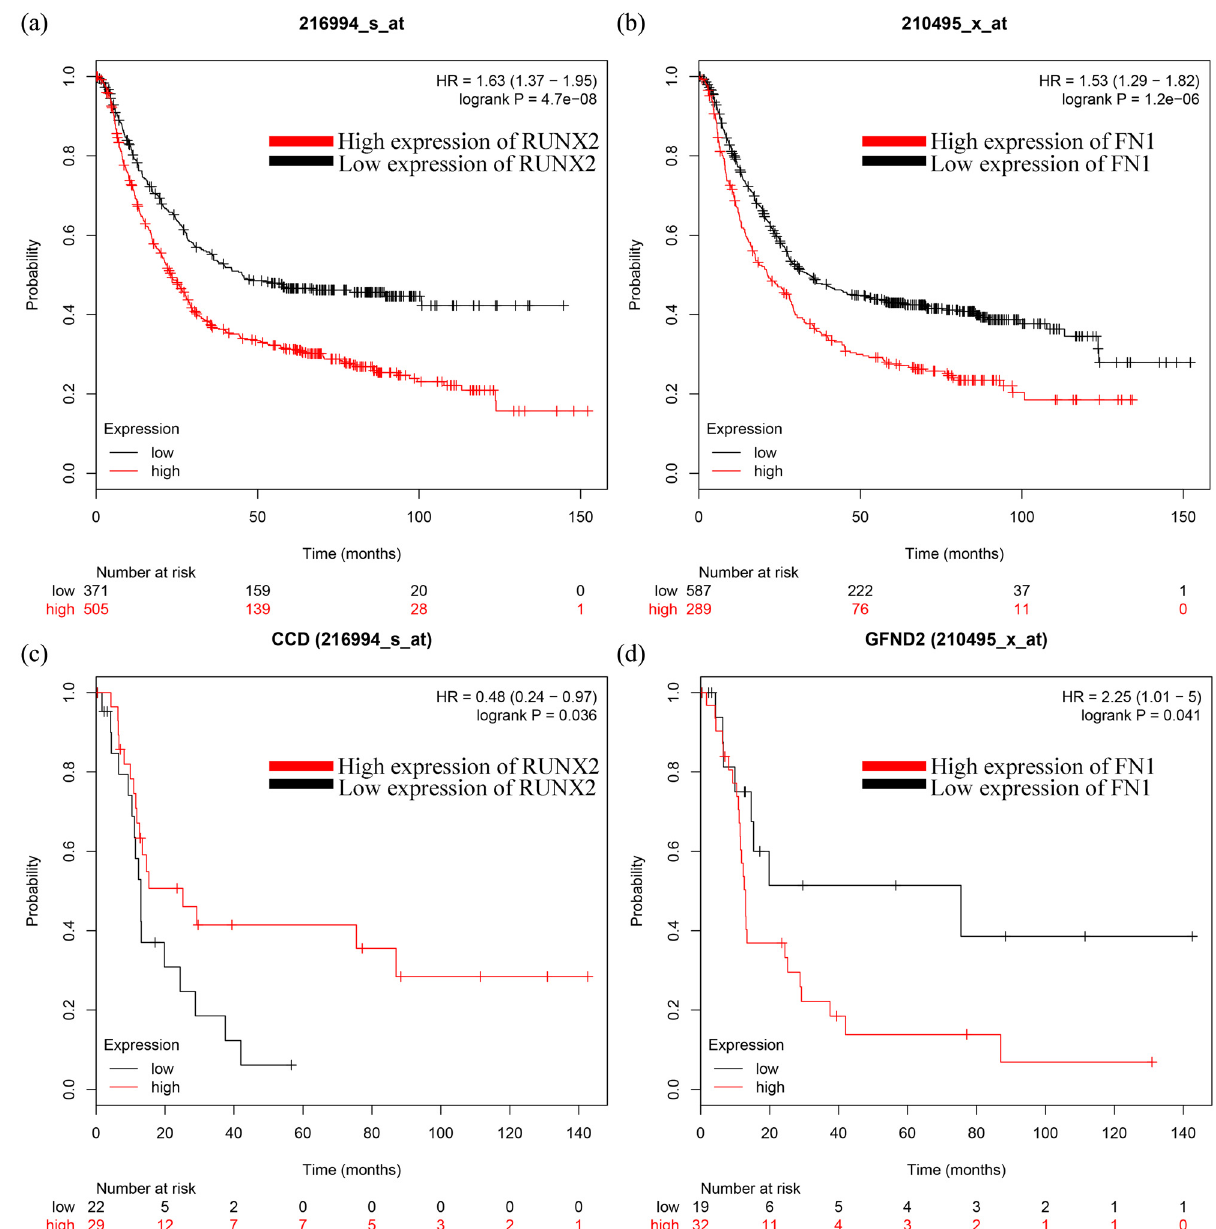
Figure 4: Prognostic value of RUNX2 and FN1 from the KM plotter ( http://kmplot.com/analysis/ ) . ( a ) Prognostic value of RUNX2. ( b ) Prognostic value of FN1. ( c ) Prognostic value of RUNX2 ( di ff use, poorly di ff erentiated patients with GC ) . ( d ) Prognostic value of FN1 ( di ff use, poorly di ff erentiated patients with GC ) . The desired A ff ymetrix IDs are valid: 216994_s_at ( RUNX2 ) , 210495_s_at ( FN1 ) . HR, hazard